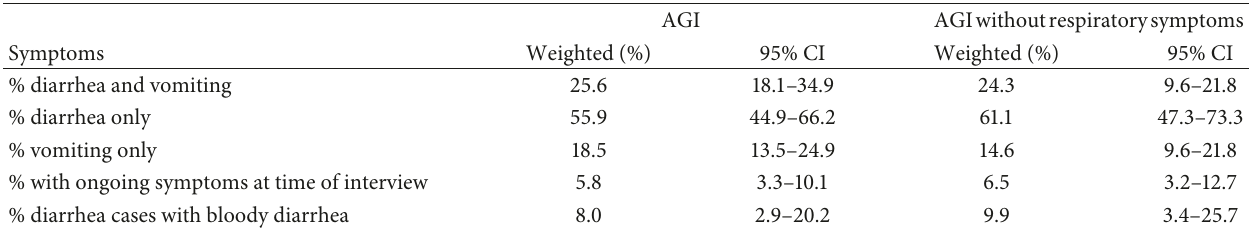
Table 4: Duration and frequency of symptoms of acute gastrointestinal illness in Canada, 2014-2015. AGI AGI without respiratory symptoms Mean 95%